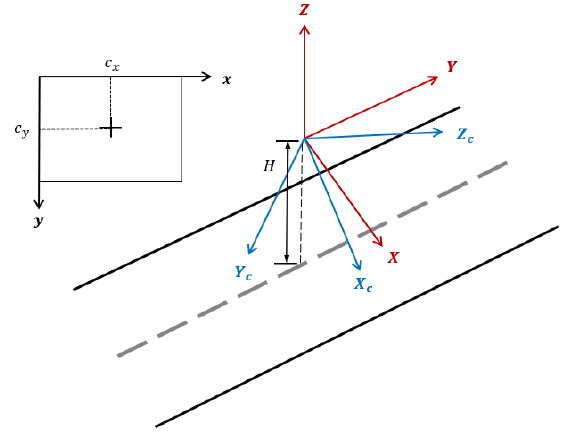
Figure 3 . Definition of coordinate systems.